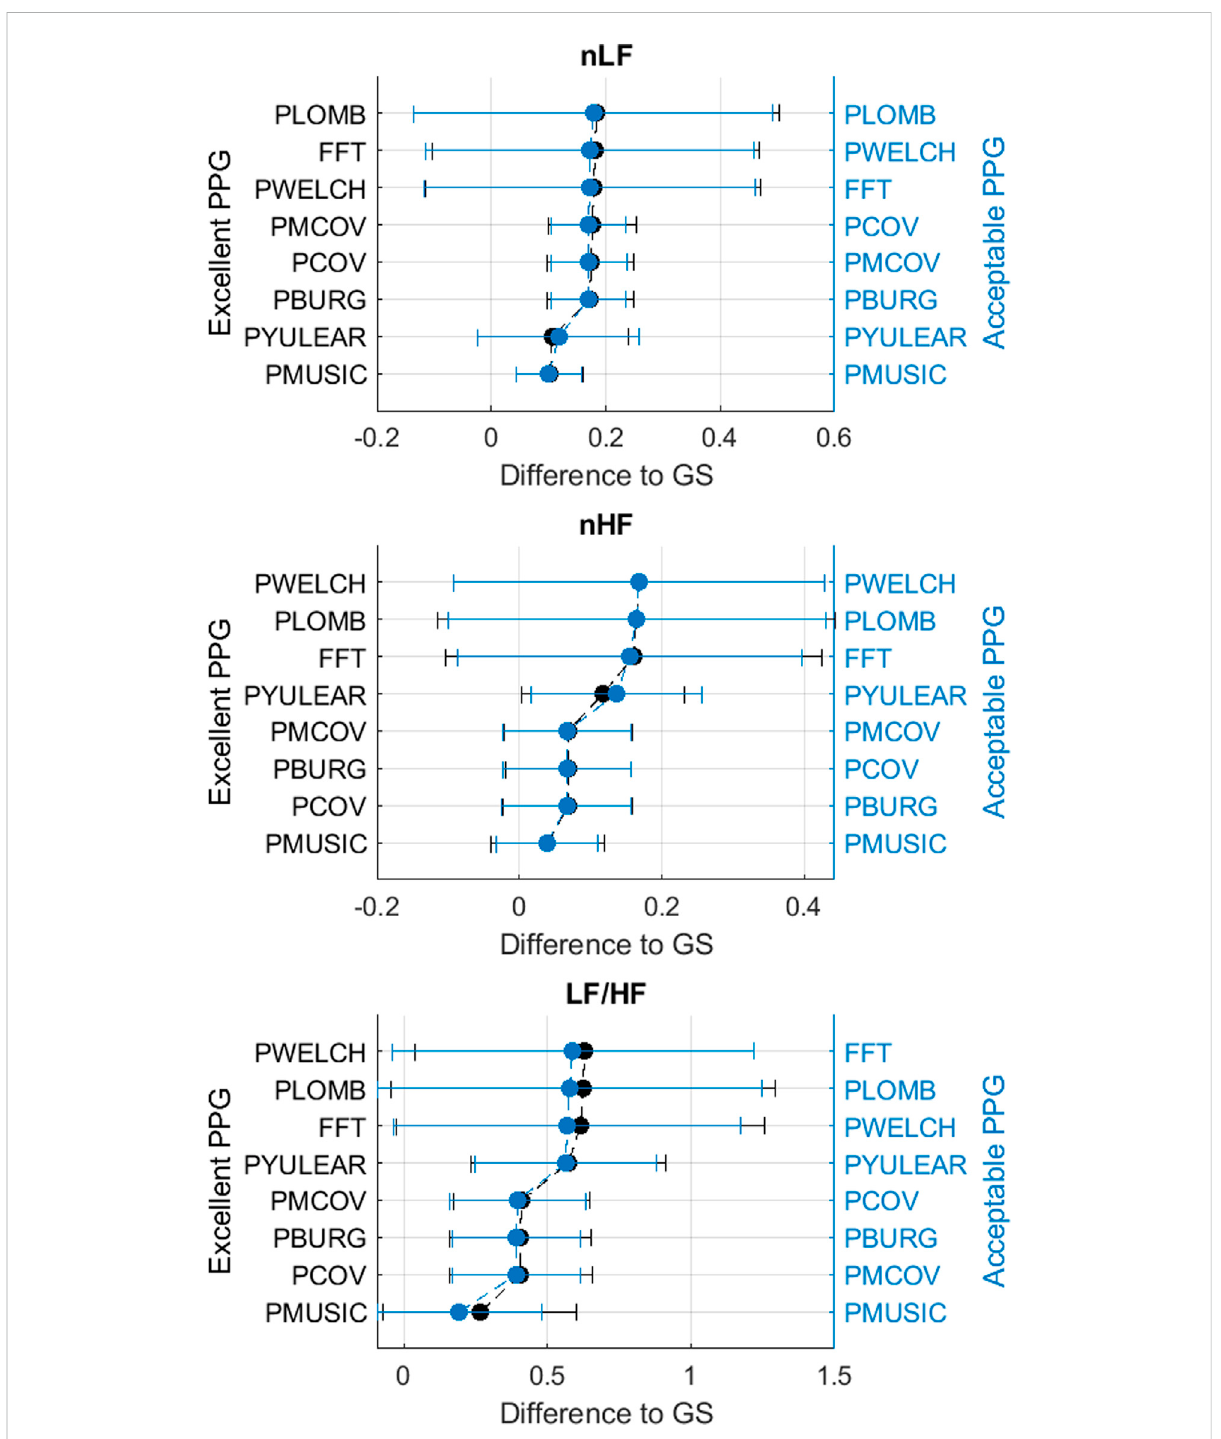
FIGURE 4 Meanandstandarddeviationsofthedifferencesobtainedbycomparingpulseratevariabilityrelativepowerfrequency-domainindicesobtained from extracted and gold-standard